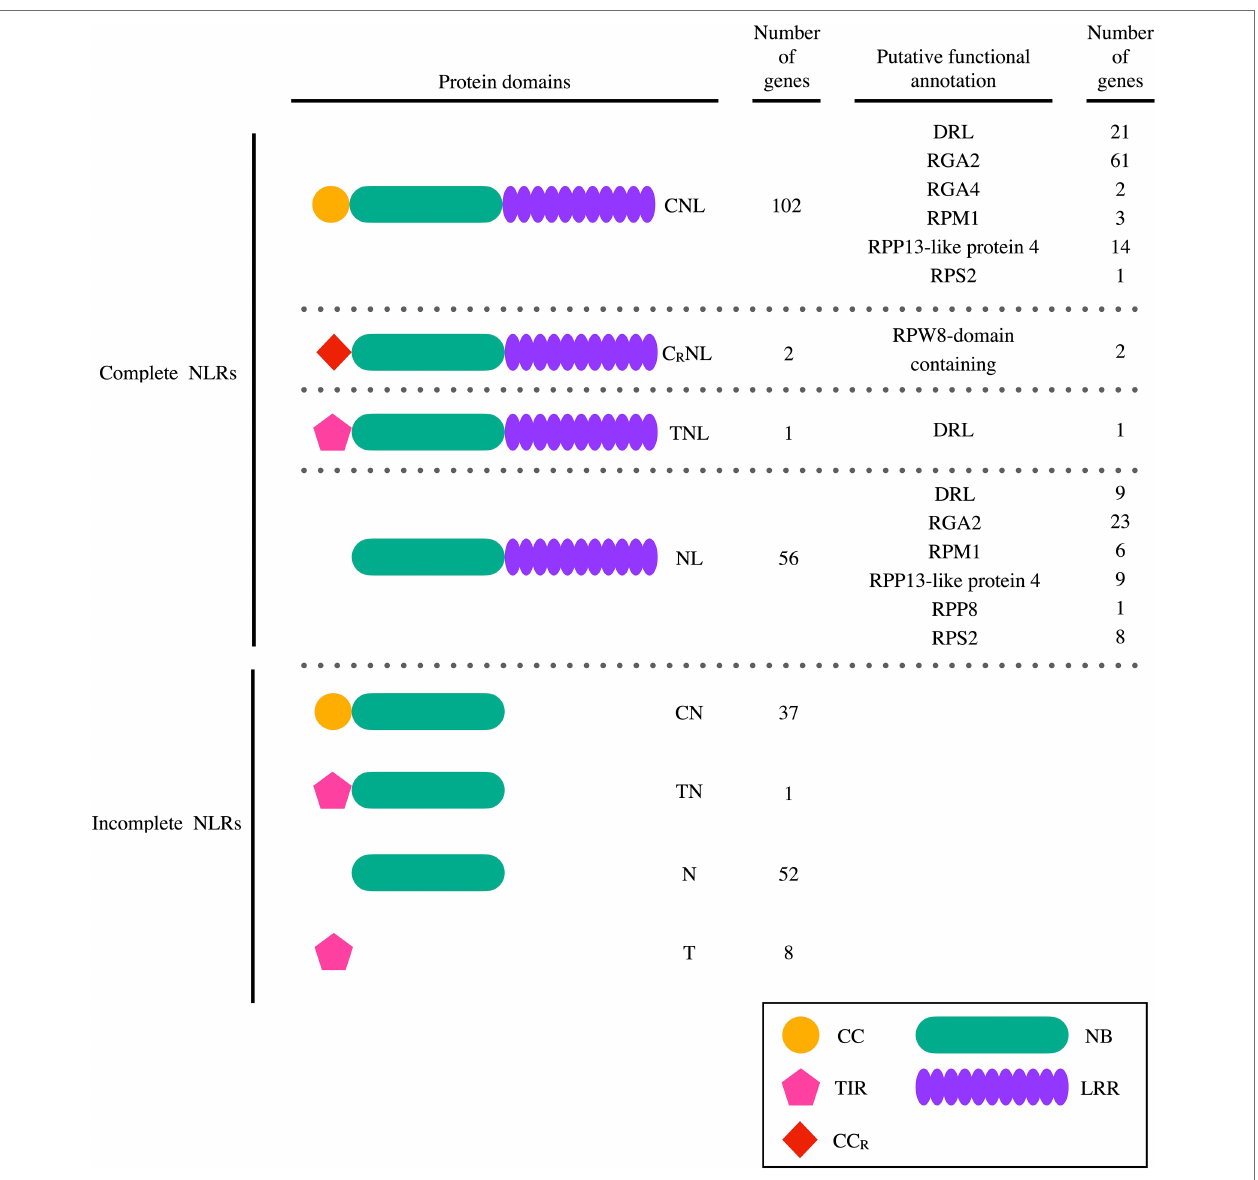
FIGURE 1 | The number of PaNLR genes identified in the West-Indian pure accession Persea americana genome and the set of protein domains each gene encodes for. Putative Nucleotide binding-Leucine rich repeat (NLR) protein functional annotations predicted using BLASTp analysis are also listed (C/CC, coiled-coil domain; C R /CC R , coiled-coil RPW8 domain; DRL, disease resistance-like protein; L/LRR, leucine rich repeat domain; N/NB, nucleotide binding domain; and T/TIR, toll/interleukin-1 receptor